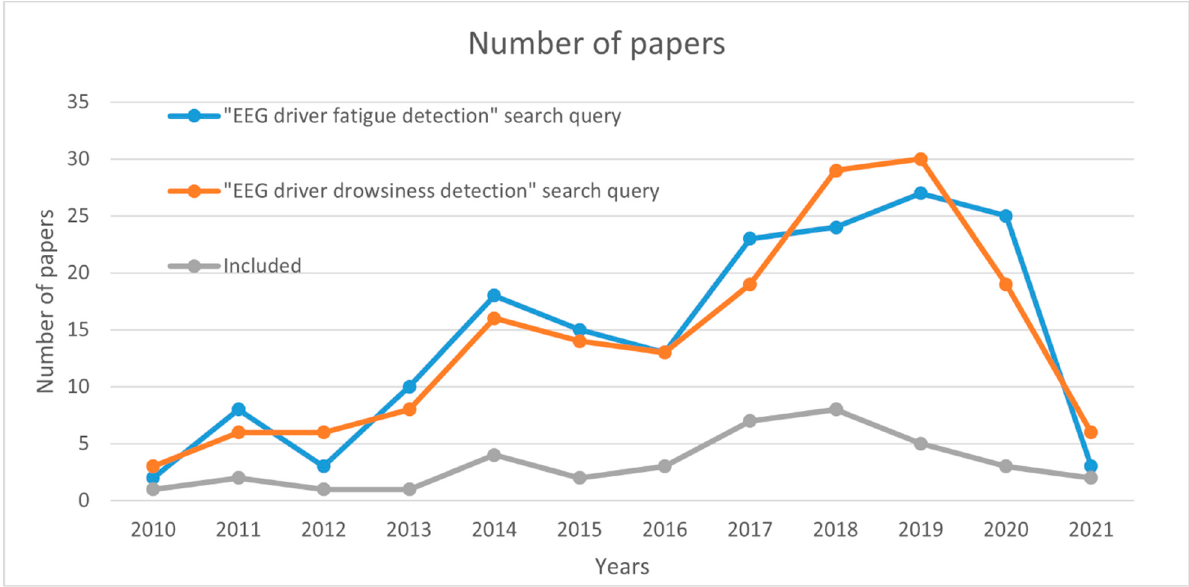
Figure 3. The number of papers included in the study and the number of papers obtained as a result of the “EEG driver drowsiness detection” and “EEG driver fatigue detection” search query, data until April 2021.